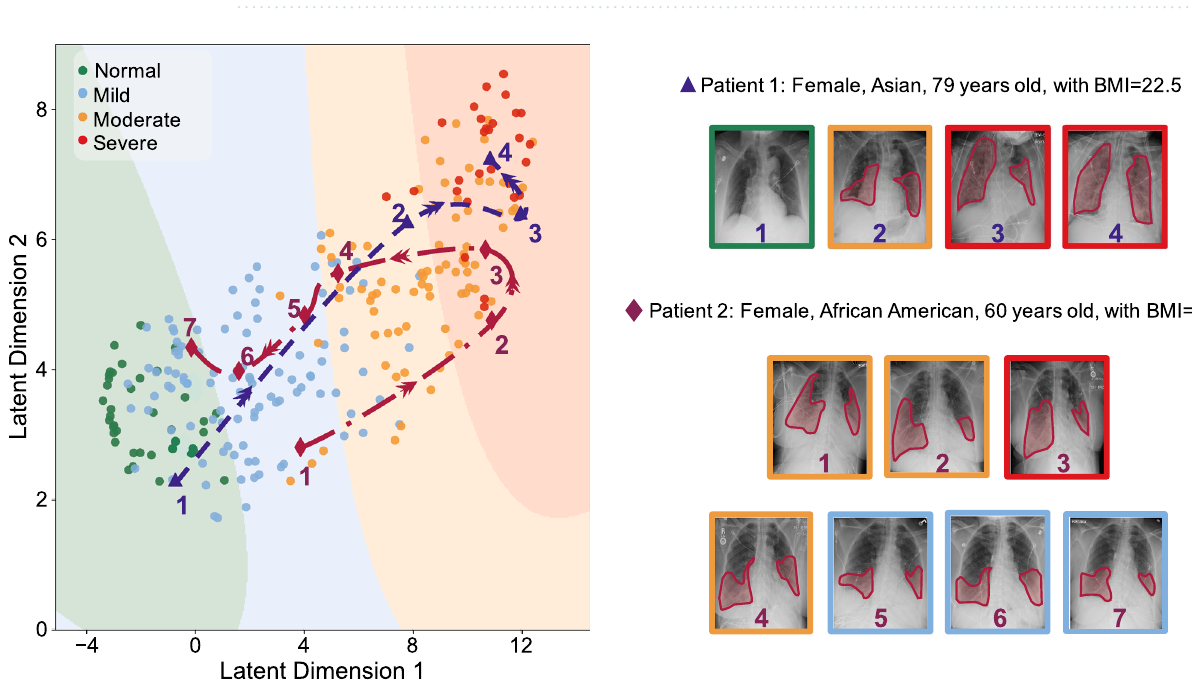
Figure 5. Latent space representation of the X-rays. The dimensionality of the penultimate layer of the network is reduced using UMAP, and the resulting latent space is clustered into 4 regions corresponding to different severity degrees using GMM. Green, blue, orange, and red are related to the normal, mild, moderate, and severe classes, respectively. The datapoints for each class are shown as circles with the corresponding color. The progressions of the disease over time for two patients are shown by the dashed blue (following a progression path) and red (following a recovery path after progression) paths in the latent space. Image segmentation is used as an indication of areas of interest and they are not necessarily quantitative measures for the severity (see Methods for more details about the severity